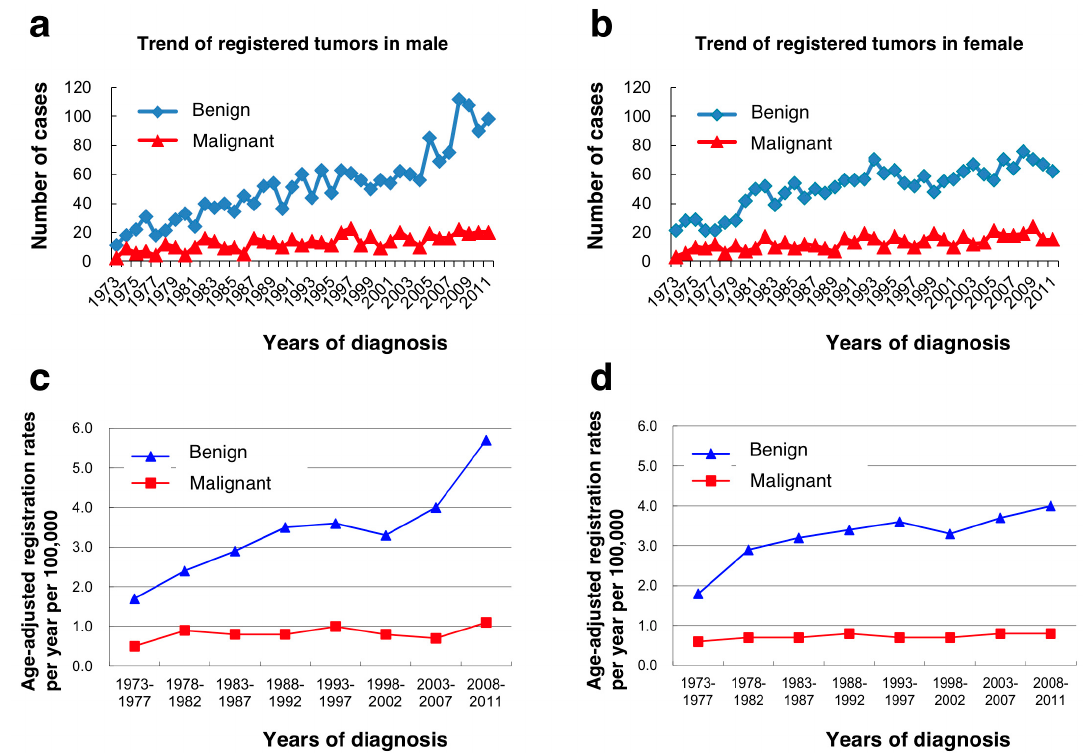
Figure 5. Annual registered number of cases ( a , b ) and age-adjusted registration rates per year per 100,000 population ( c , d